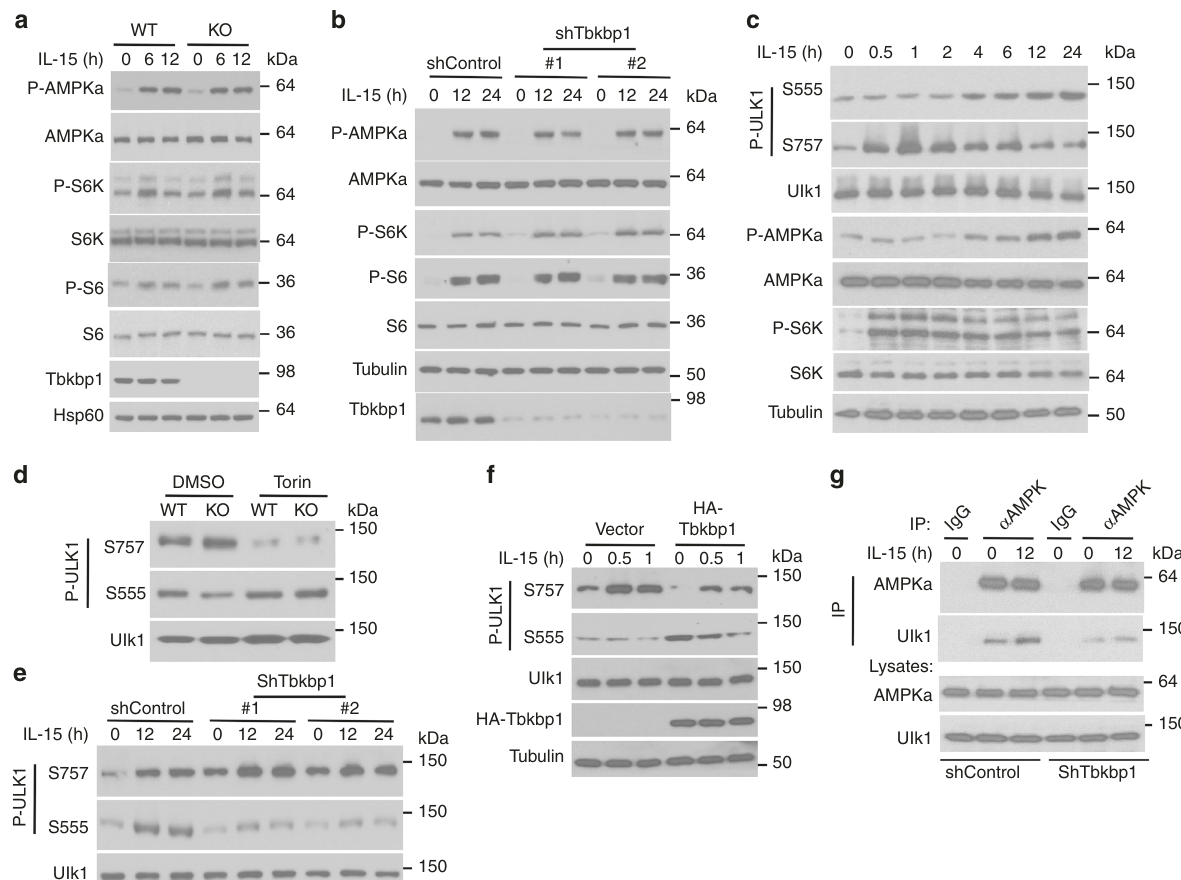
Fig. 7 Tbkbp1 facilitates AMPKa-mediated Ulk1 activation by antagonizing mTORC1. a , b IB analysis of the indicated phosphorylated (P-) and total proteins in whole-cell lysates of IL-15-stimulated WT and Tbkbp1 -KO thymic NKT cells ( a ) or NKT hybridoma cells transduced with a non-silencing control shRNA or two different Tbkbp1-speci fi c shRNAs ( b ). c IB analysis of the indicated phosphorylated (P-) and total proteins in whole-cell lysates of